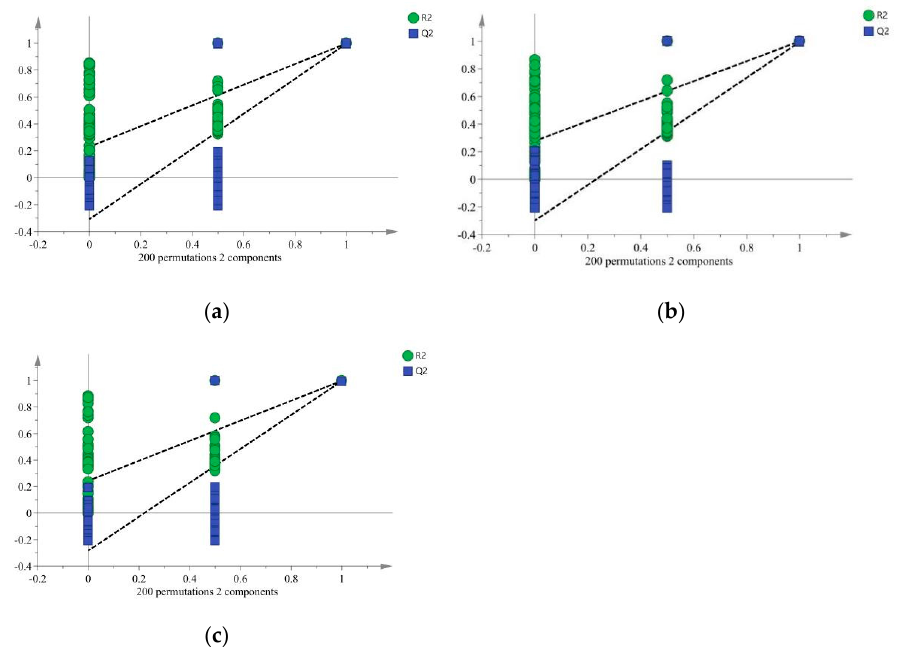
Figure 4. Permutation test of PLS-DA model. ( a ) T. cordata ; ( b ) T. miqueliana ; ( c ) T. tomentosa .